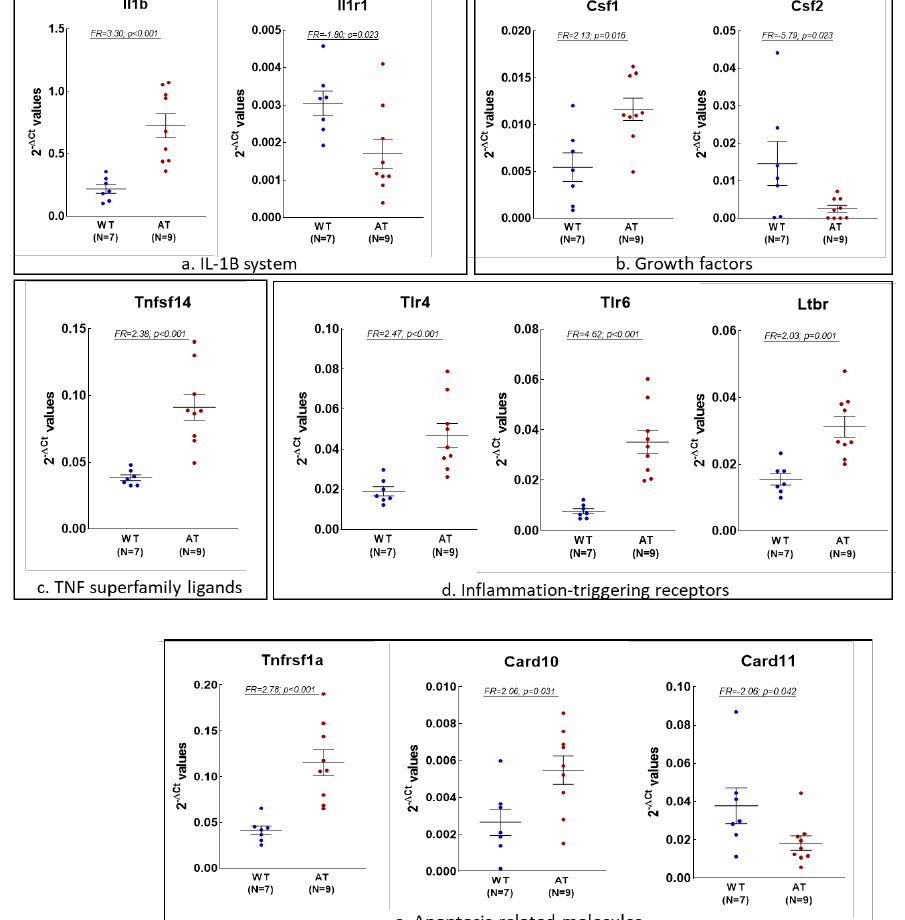
Figure 2. Inflammation and redox-related genes that are differentially expressed in the hippocam- pus of AT mice (N = 10) vs. WT mice (N = 8), exhibiting |FR| values > 1.8. Data are presented as 2 −∆CT values, and lines represent the expression average ± standard error of the mean (SEM). Com- parisons between mice groups were made using the Mann – Whitney U-test, and differences were considered significant for p <